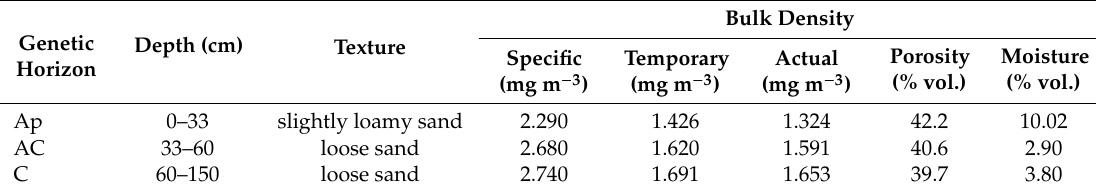
Table 1. Physical properties of the